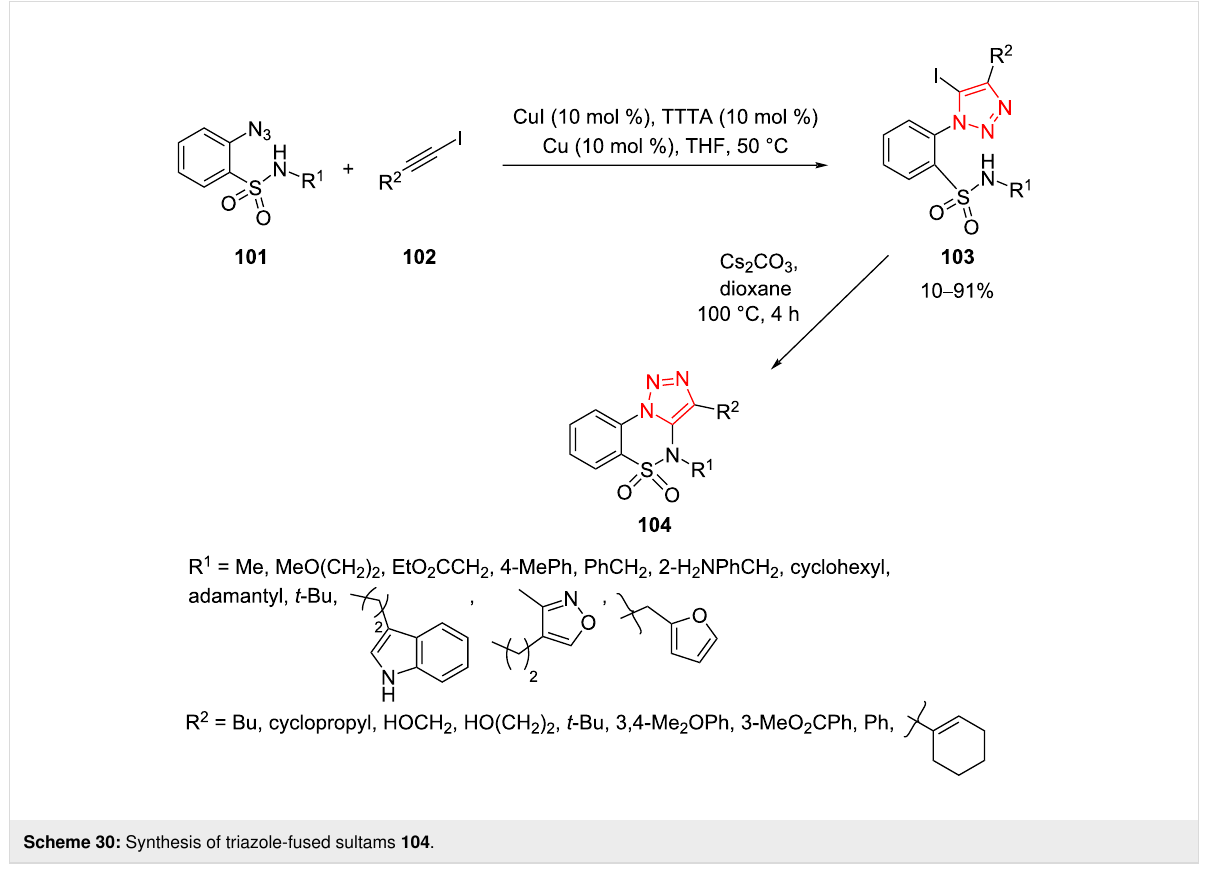
Scheme 30: Synthesis of triazole-fused sultams 104